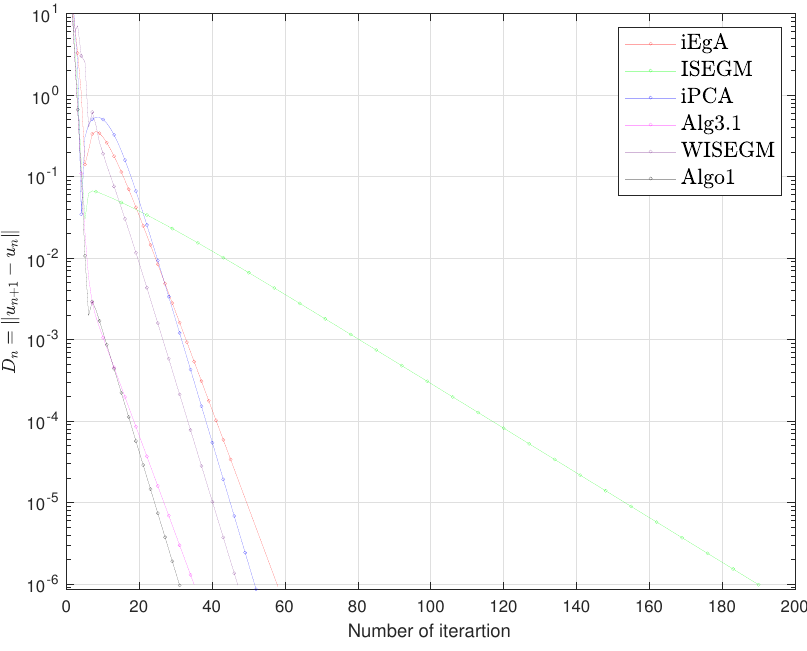
Figure 7. Example 3: Numbers of iterations are 58, 190, 52, 35, 47, 31 respectively.